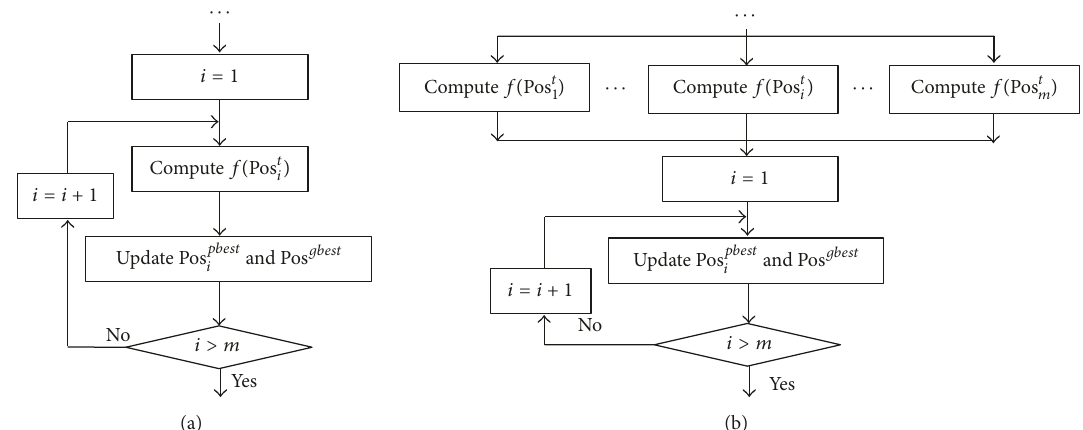
Figure 2: The updating strategies: (a) the synchronous updating strategy of S-PGD and (b) the asynchronous updating strategy of